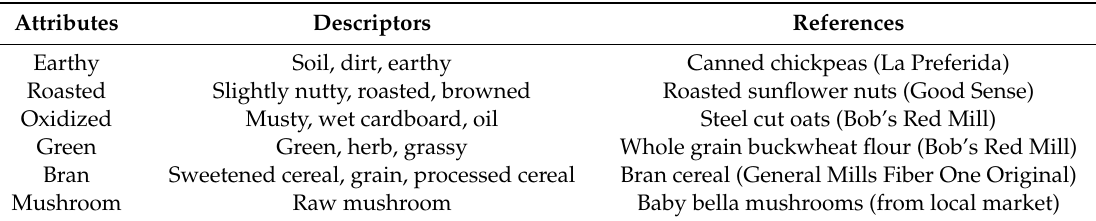
Table 2. Definition of sensory attributes and references used for descriptive